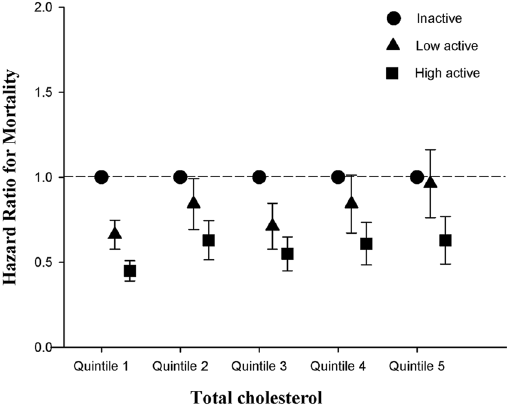
Figure 1. Adjusted hazard ratios for mortality based on the quintiles of total cholesterol and physical activity status among older individuals.